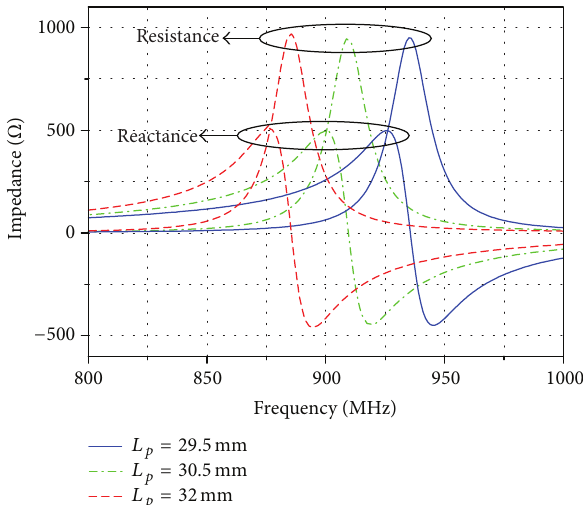
Figure 5: Antenna gain for different thicknesses of the patch.